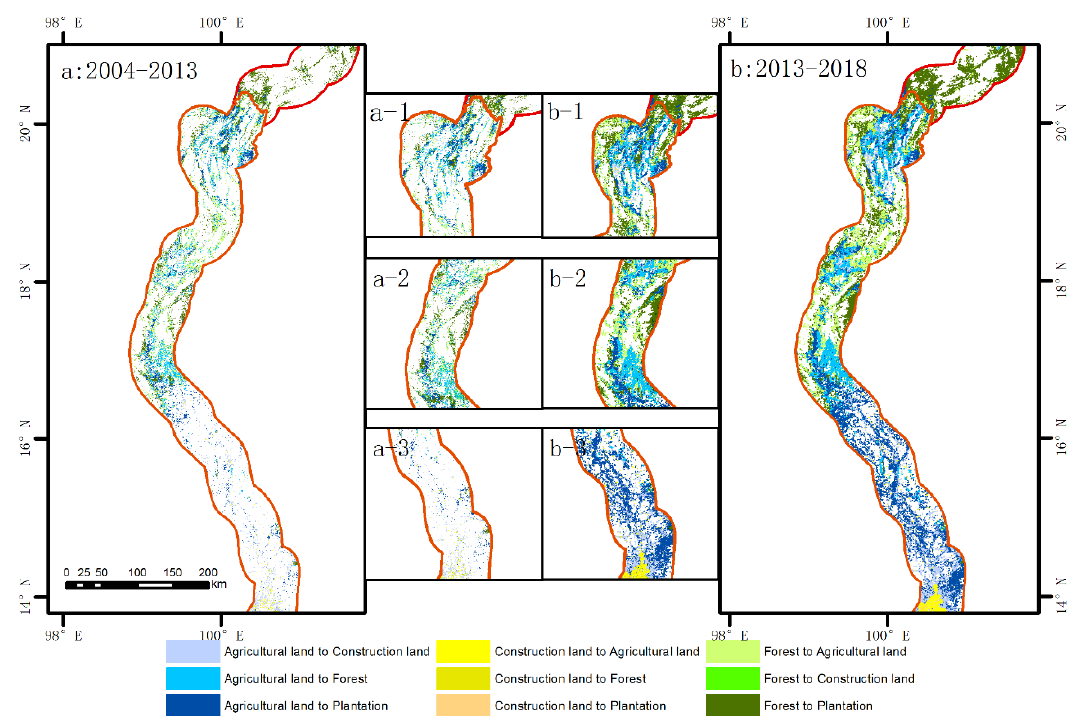
Figure 2. Comparison of spatial changes in major land use types in the 30 km buffer area in ( a ) 2004–2013 and ( b ) 2013–2018.